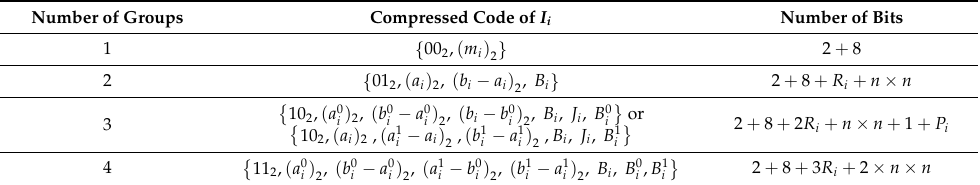
Table 1. Number of bits required to record a compressed